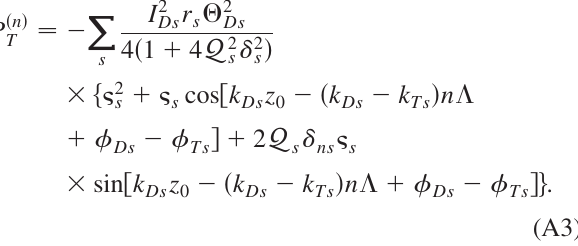
FIG. 11. (Color) Simplified equivalent circuit of the cavity driven by a current I